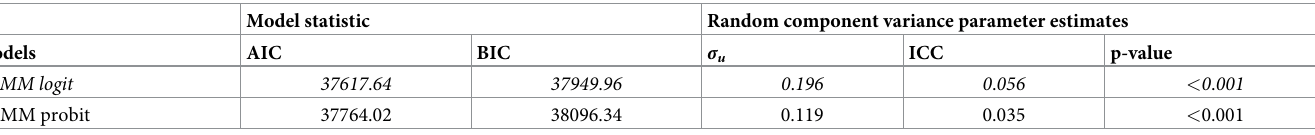
Table 4. Comparison of models to assess the random effect